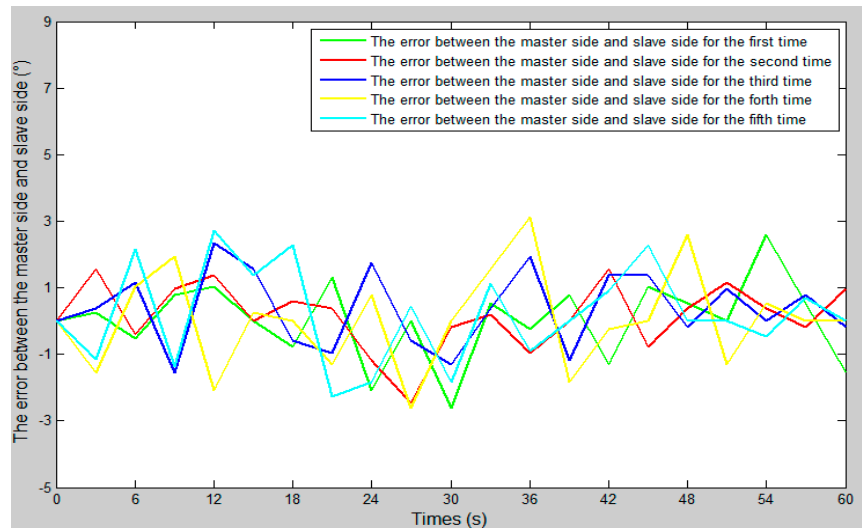
Figure 19. The error curve between the slave angle of rotation and the master angle of rotation